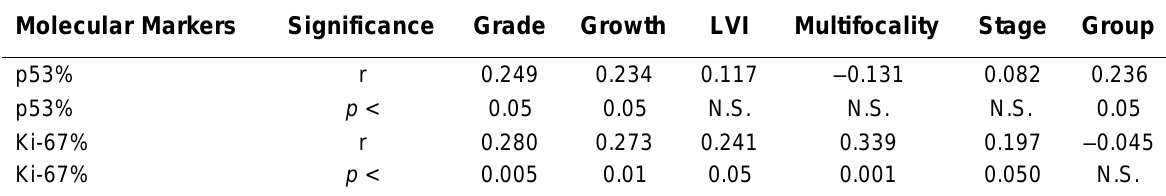
Pearson Correlation Analysis of Molecular Markers with Conventional Morphological Parameters and Group Molecular Markers